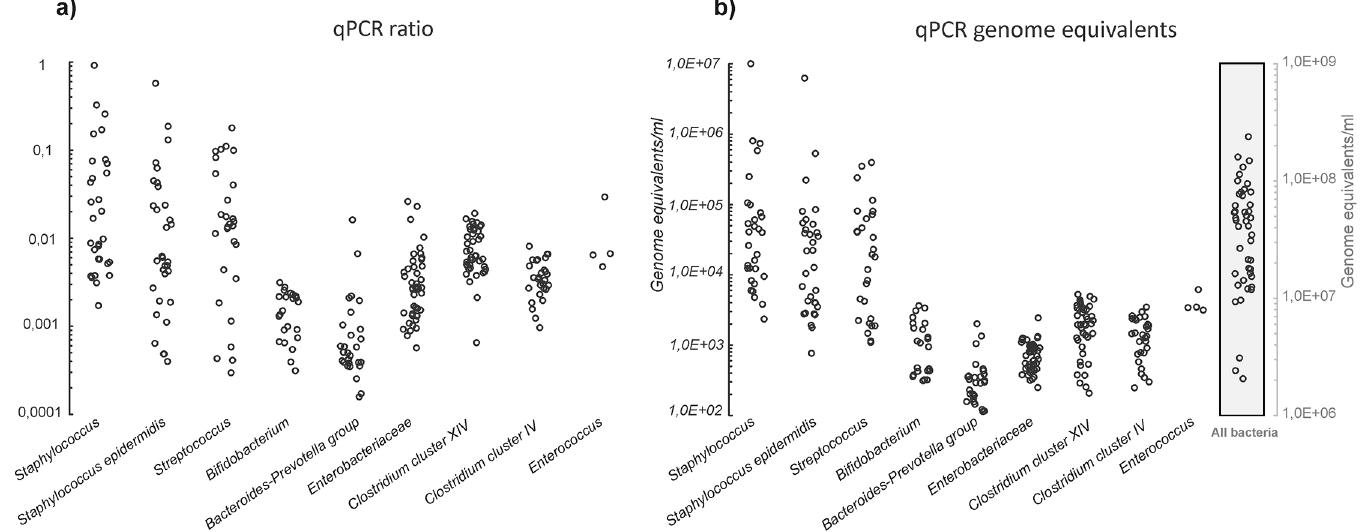
Fig 3. (a) Normalized distribution of detected bacterial groups across the sample set (one dot represents % of the detected group ’ s specific DNA in relation to all bacterial DNA in the sample). (a, b). (b) Distribution of genome equivalents ml-1 colostrum for detected bacterial groups across the investigated maternal